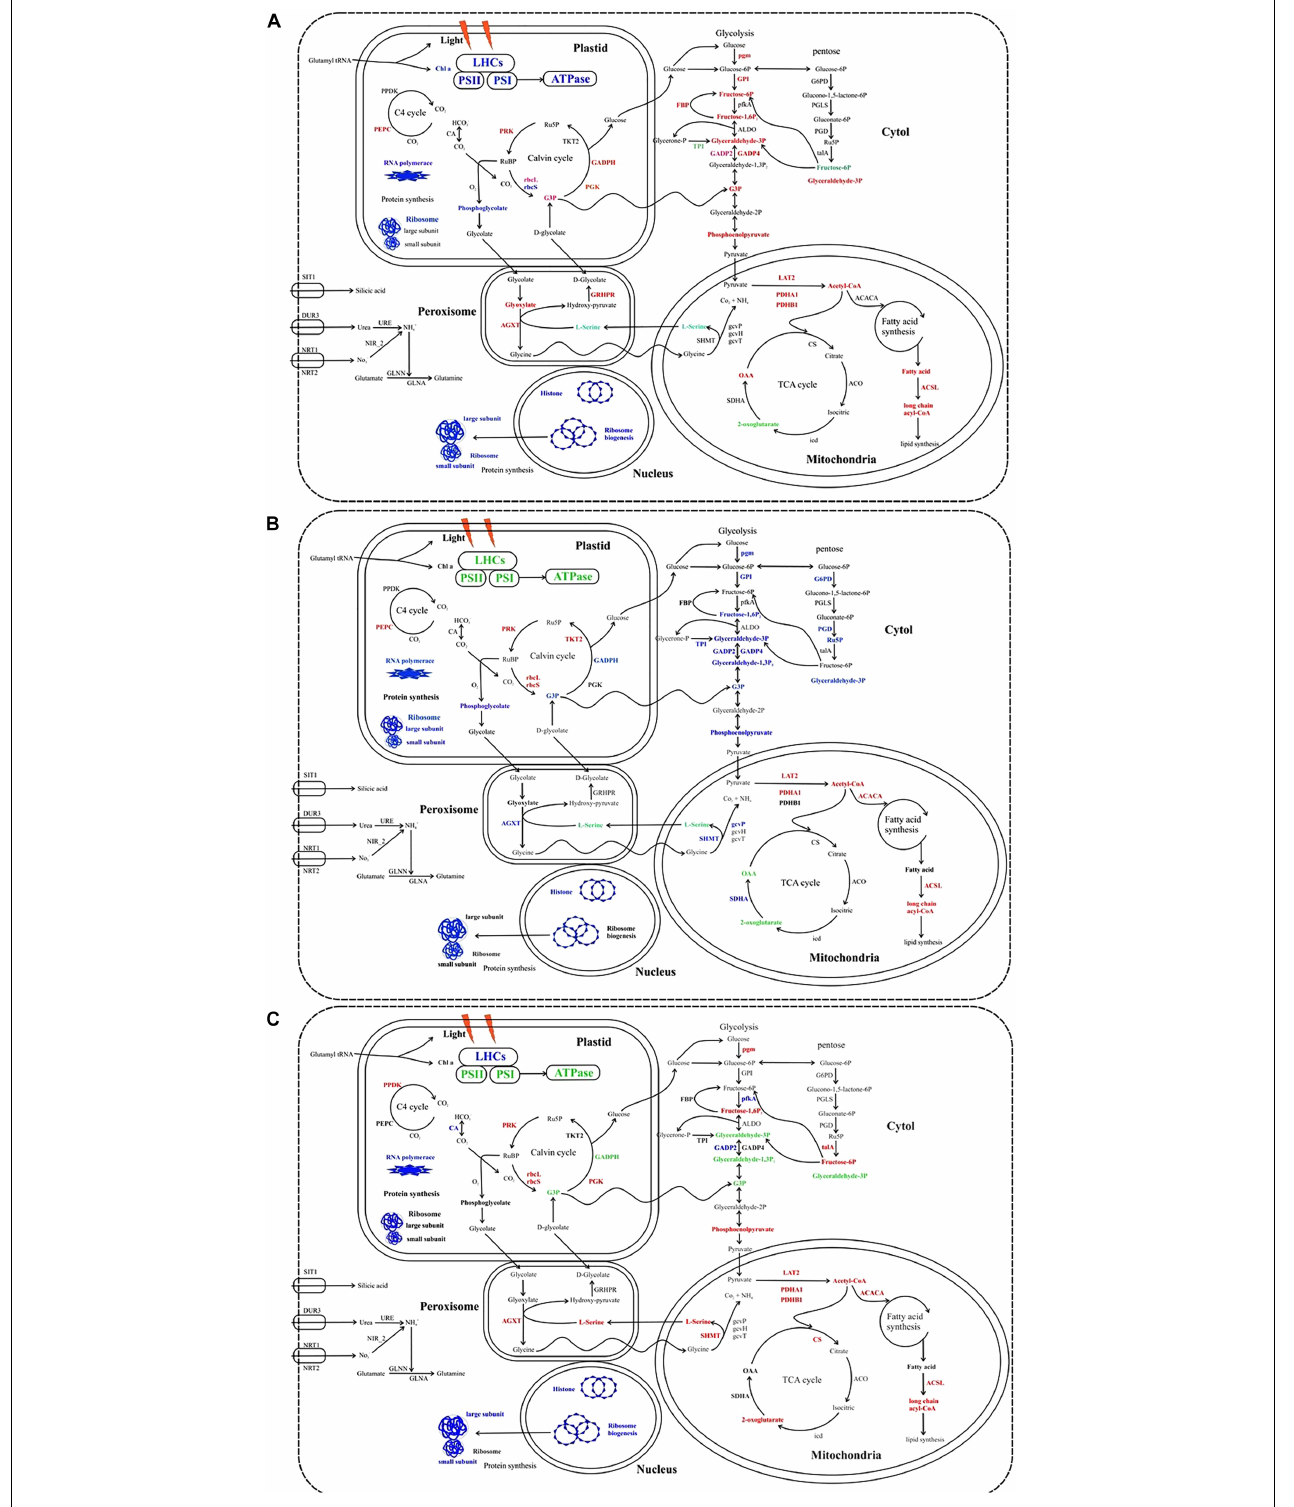
FIGURE 7 | Cellular metabolic pathways and processes influenced by the different stress condition in S. dohrnii. (A) HTHS versus HTLS; (B) HTHS versus LTHS; (C) HTHSversusLTLScondition.Red,blue,green,andblacktextindicatesupregulation,downregulation,bothupanddownregulation,andnochangesofpathwaysor